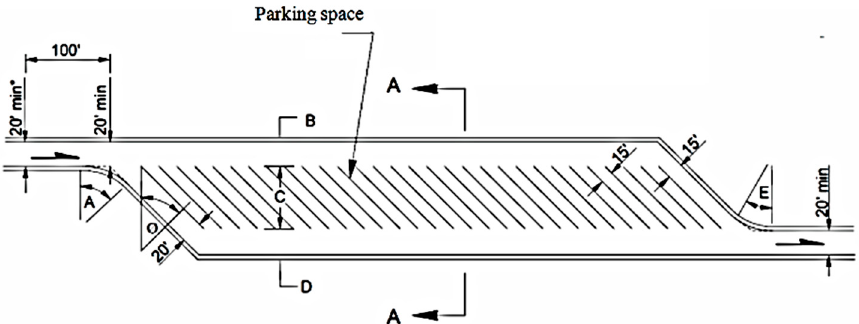
Figure 2. The fundamental planning of the placement of parking spaces for trucks recommended in